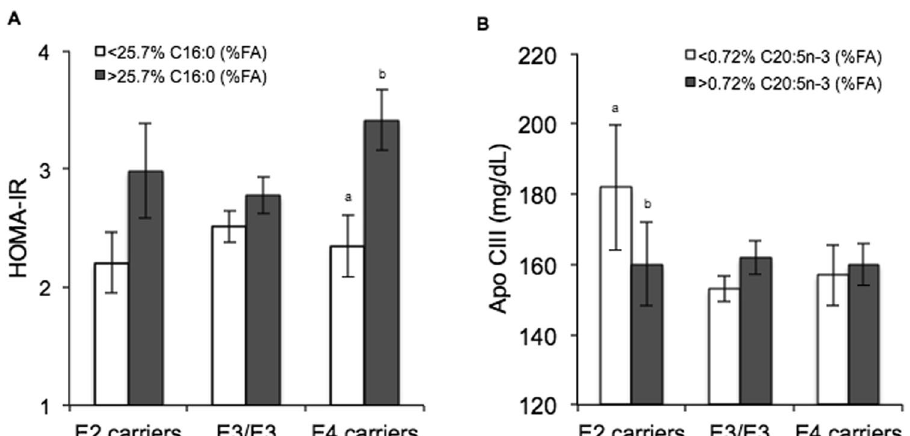
Figure 1. Effect of the APOE genotype and < / > median baseline plasma fatty acid concentration on ( A ) HOMA-IR ( APOE × C16:0 interaction, P = 0.018) and ( B ) apo CIII ( APOE × C20:5n-3 interaction, P = 0.041) in metabolic syndrome subjects. Values are means ± s.e.m. Letters (a and b) are used to denote significant differences between plasma fatty acid groups within the same genotype, P < 0.05 using post hoc